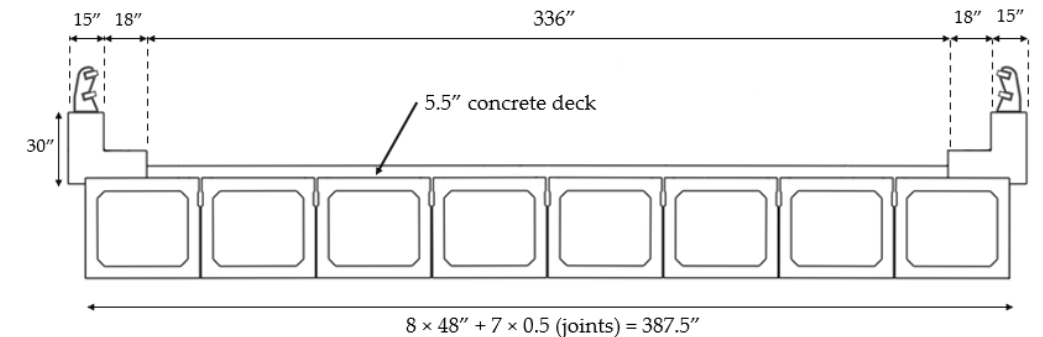
Figure 3. Cross section of the bridge.